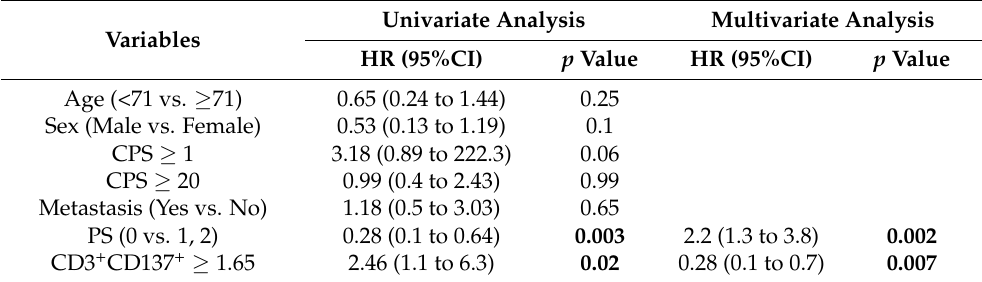
Table 2. Predictive and prognostic factors for progression free